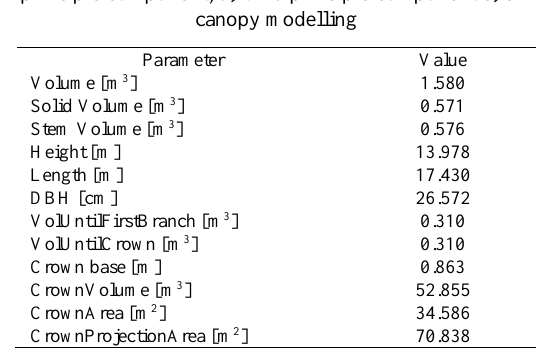
The results indicated that, terrestrial laser scanner is an effective measurement tool to provide high accuracy and objective results for 3D modelling of tree structure parameters. One of the most important stage in modelling is noise cleaning. And also scan station number is important for right modelling. In the determining of scan station placement, users have to consider environmental obstacle which may be restrict